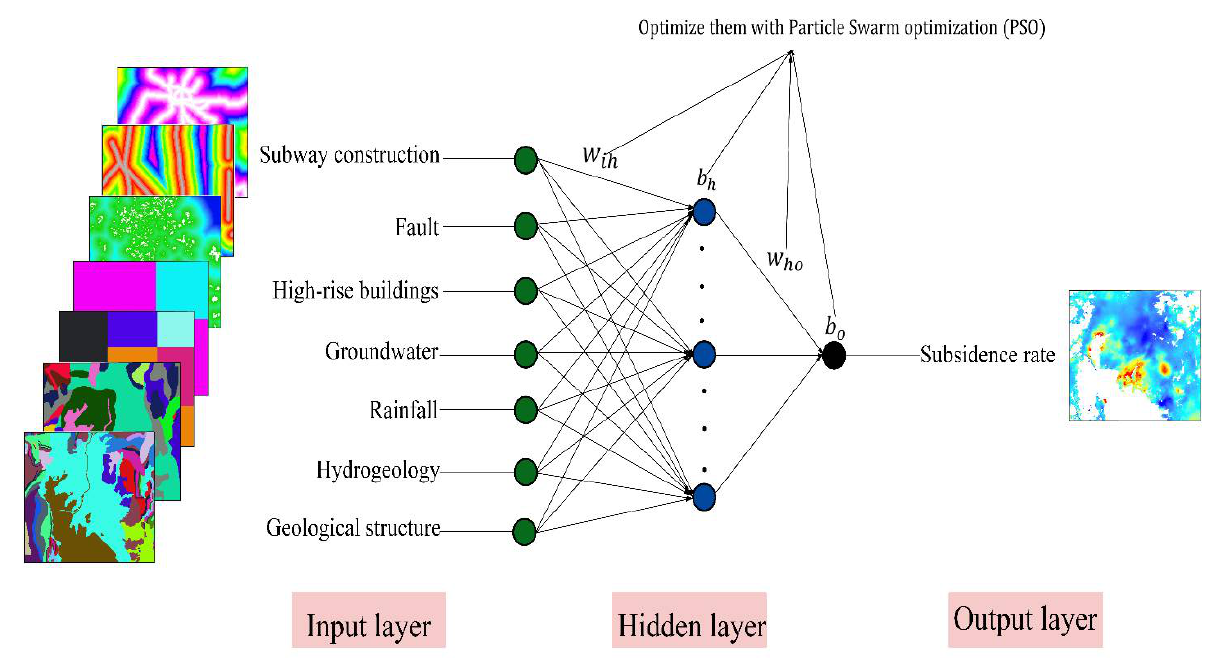
Figure 5. The constructed multi-factorial PSO-BP prediction model. In the figure, ih w represents the connection weight between the input layer and the hidden layer, ho w represents the connec- the connection weight between the input layer and the hidden layer, w ho represents the connection weight between the hidden layer and the output layer, b h represents the threshold of each neuron in tion weight between the hidden layer and the output layer, h b represents the threshold of each the hidden layer, and b o represents the threshold of each neuron in the output neuron in the hidden layer, and o b represents the threshold of each neuron in the output layer.